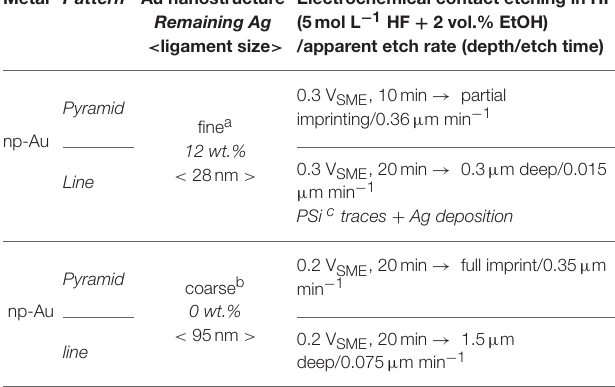
TABLE 2 | Etching conditions and results obtained by electrochemical contact etching using np-Au electrodes with pyramids and U-shaped lines arrays as surface patterns ( cf. Supplementary Information for more details on contact etching